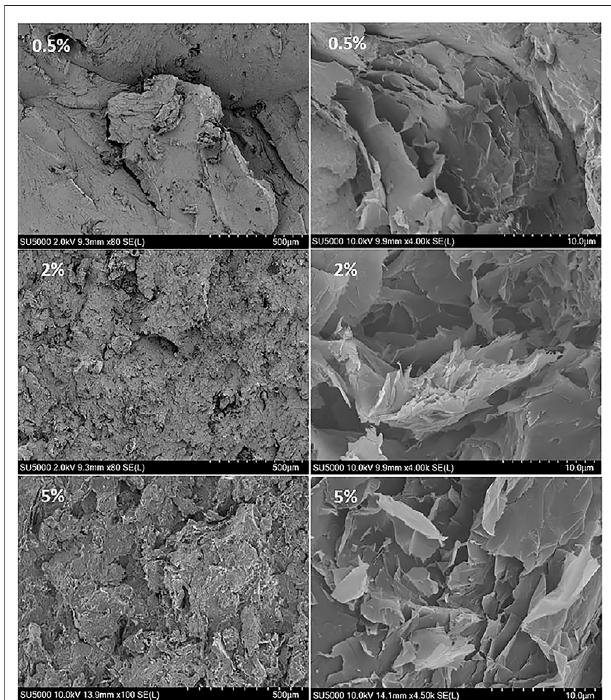
FIGURE 1 | SEM images of the neat PEEK and the composites containing 0.5, 2 and 5 vol%